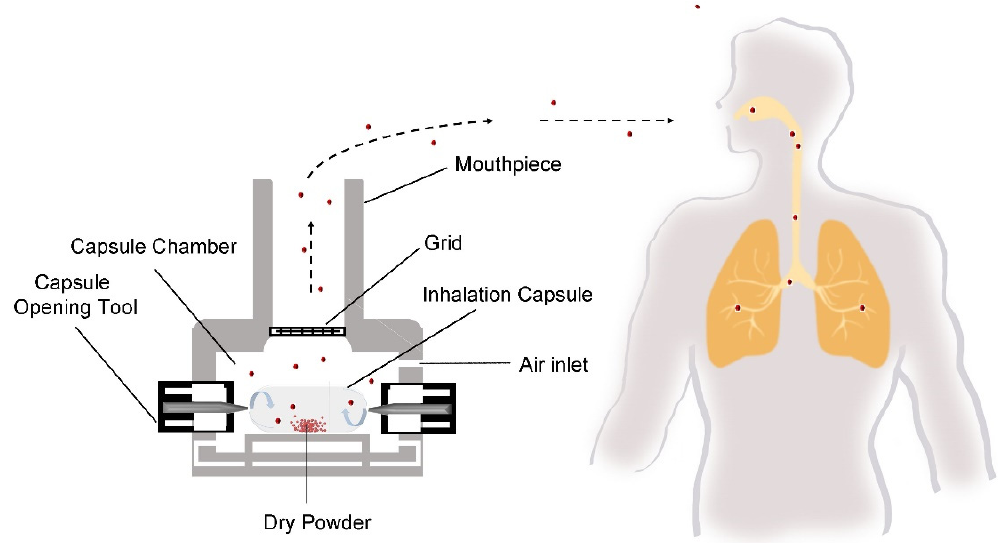
Figure 2. Schematic of an example of successful delivery of the drug to the